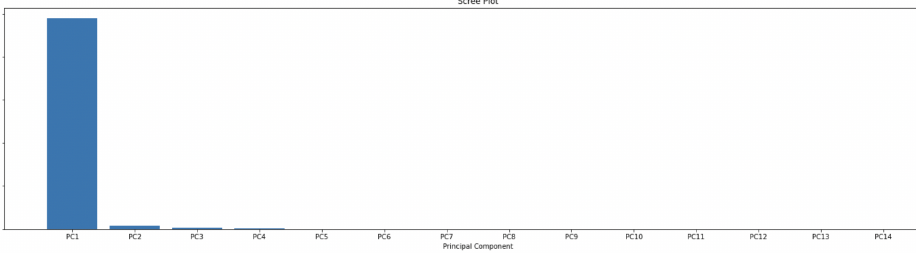
Figure 12. Scree plot of the heart disease